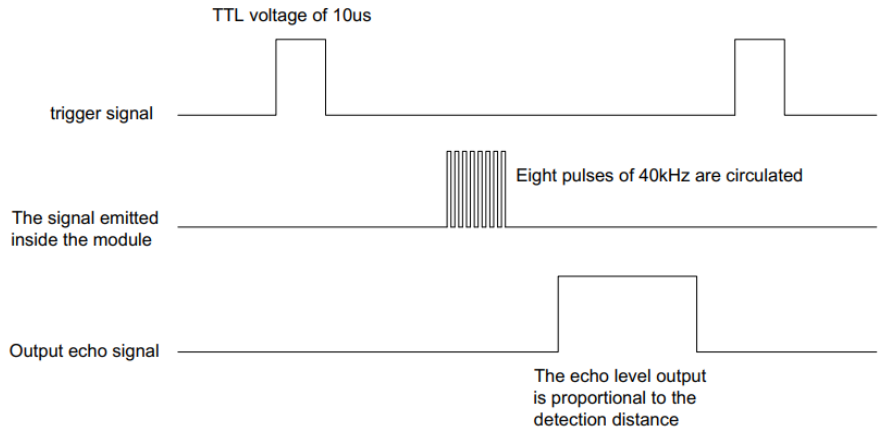
Figure 12. Sequence diagram of ultrasonic sensor.